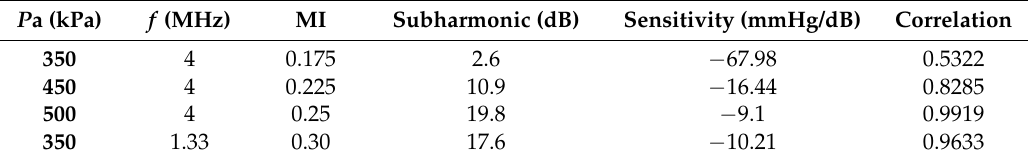
Table 2. Ambient pressure sensitivity of the subharmonic amplitude.